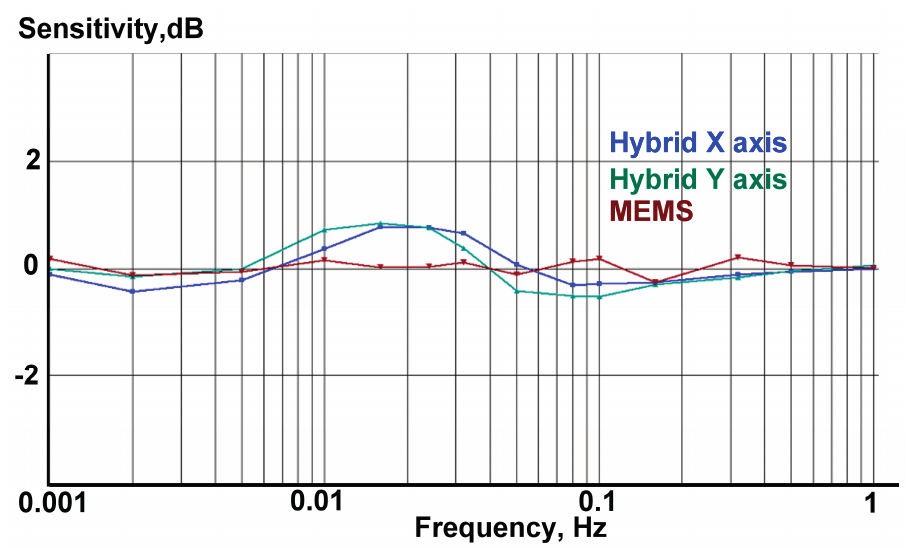
Figure 13. Measured amplitude response for two horizontal channels of the hybrid sensor (blue and teal) and a MEMS (dark red). 0 dB = 1 gV